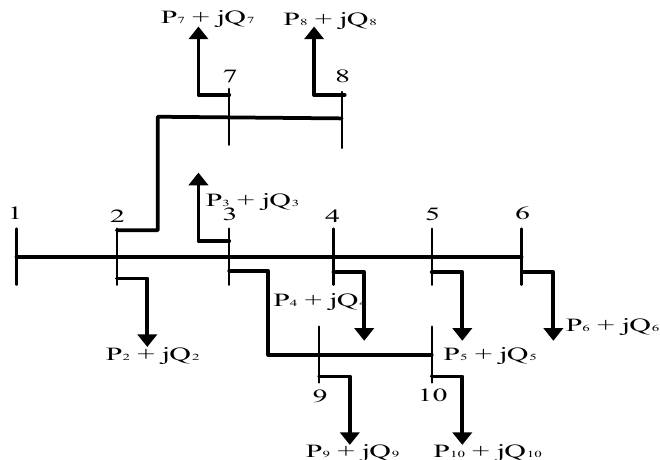
Figure 7. A simple radial distribution network. From Figure 7,